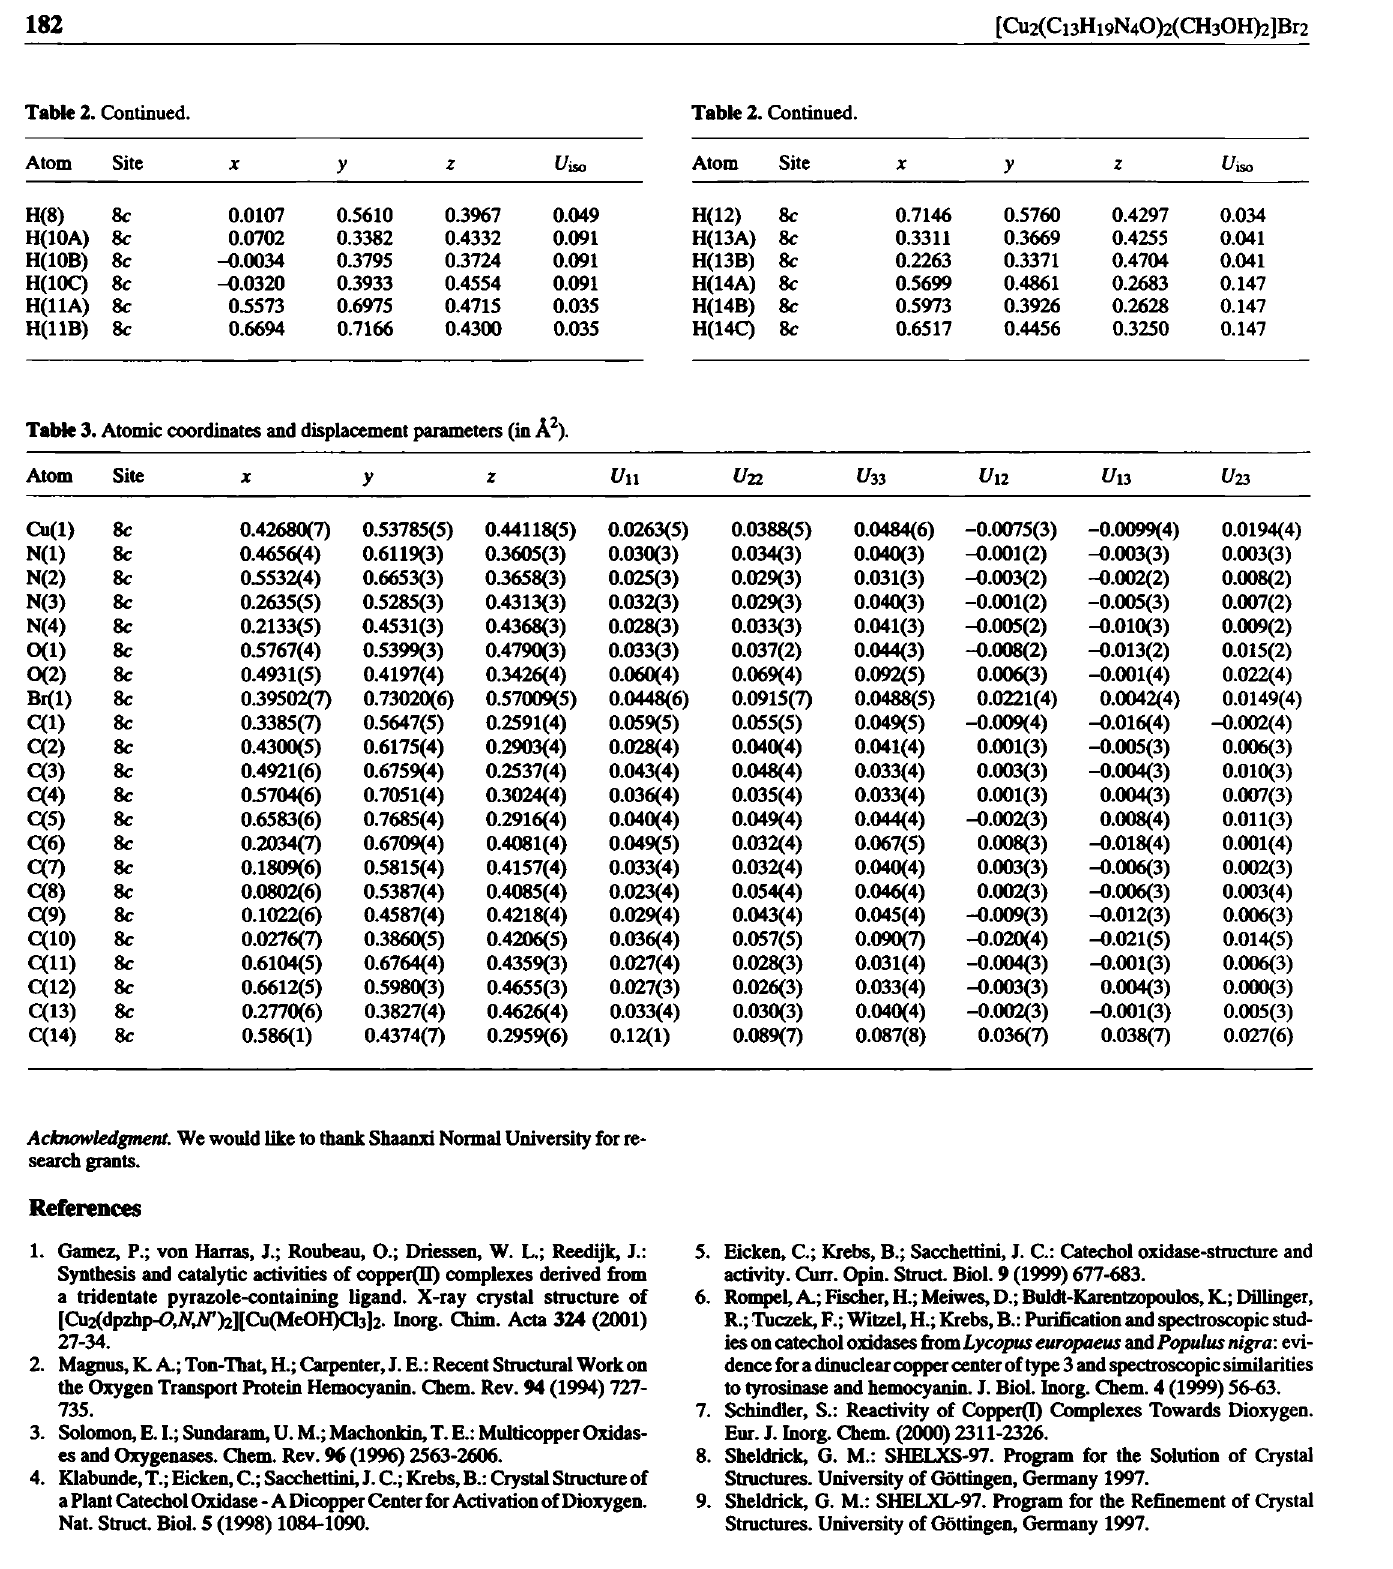
Table 3. Atomic coordinates and displacement parameters (in A 2